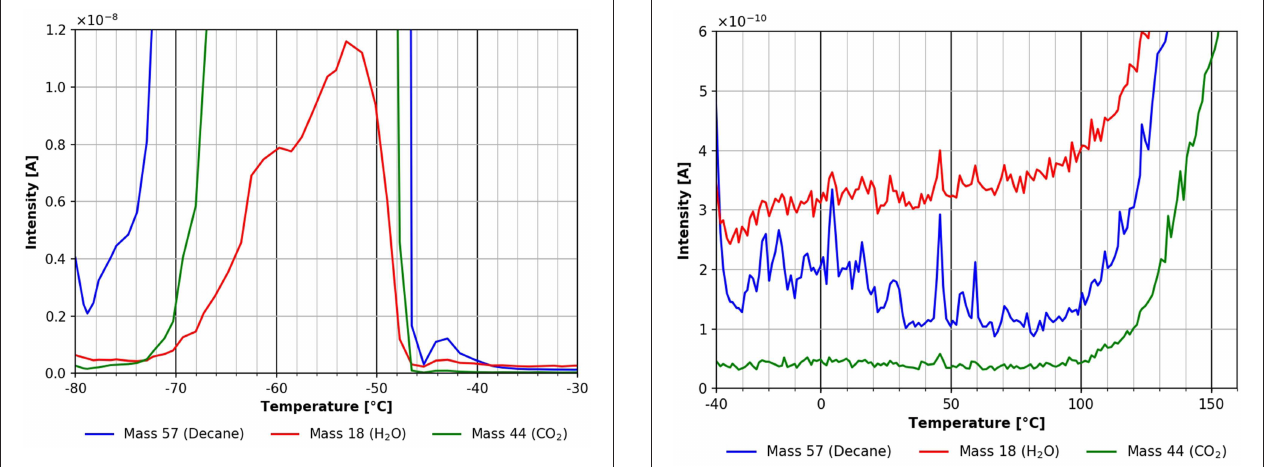
FIGURE 8 | Desorption of n-decane (mass 57, blue), carbon dioxide (mass 44, green) and water (mass 18, red) in the temperature range between − 40 and + 160 ◦